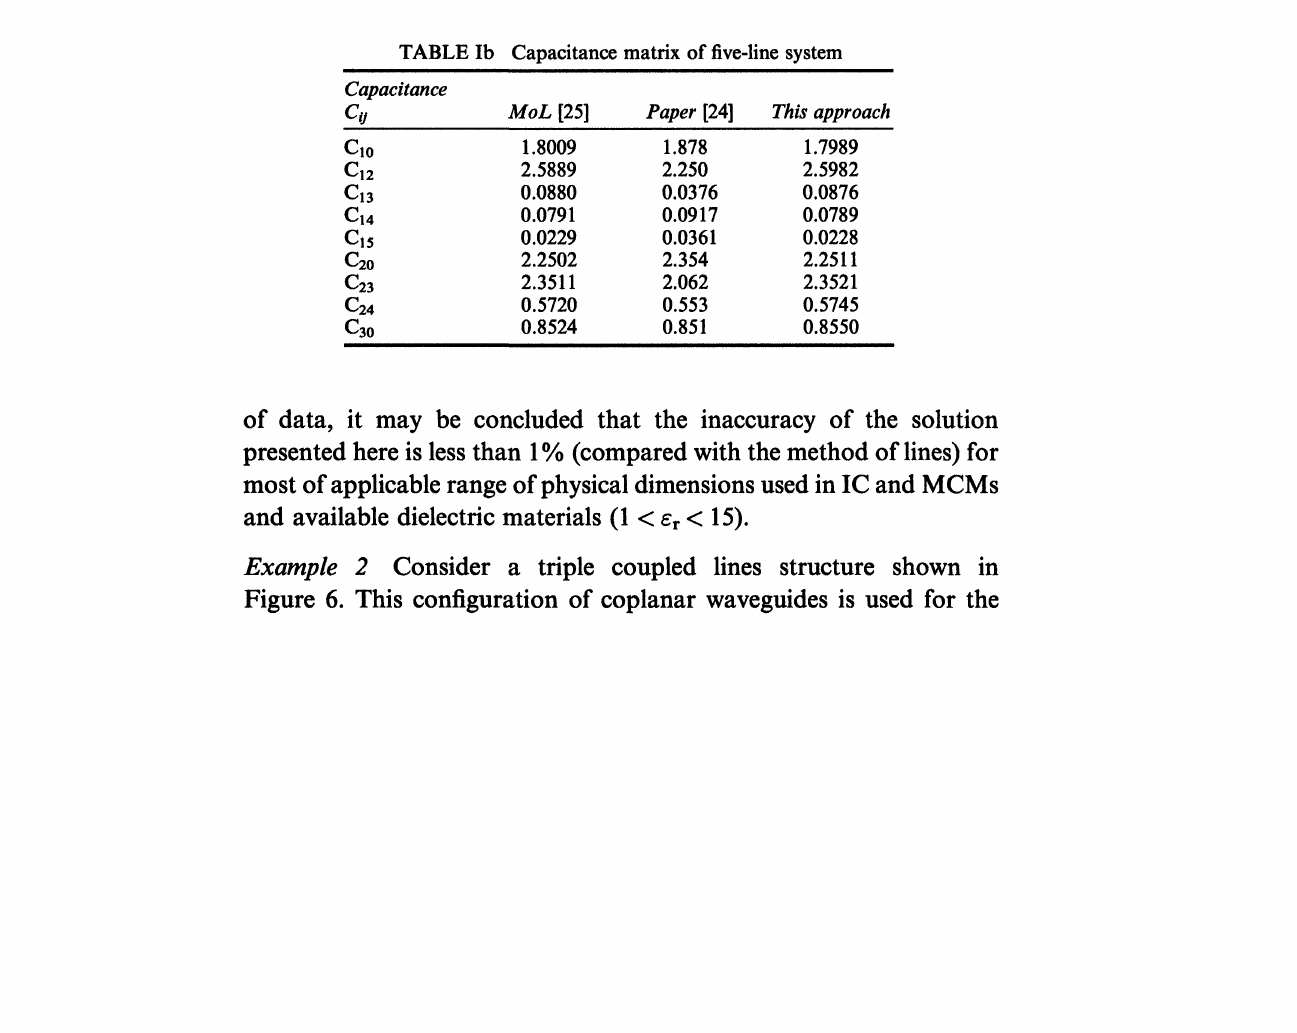
TABLE Ib Capacitance matrix of five-line